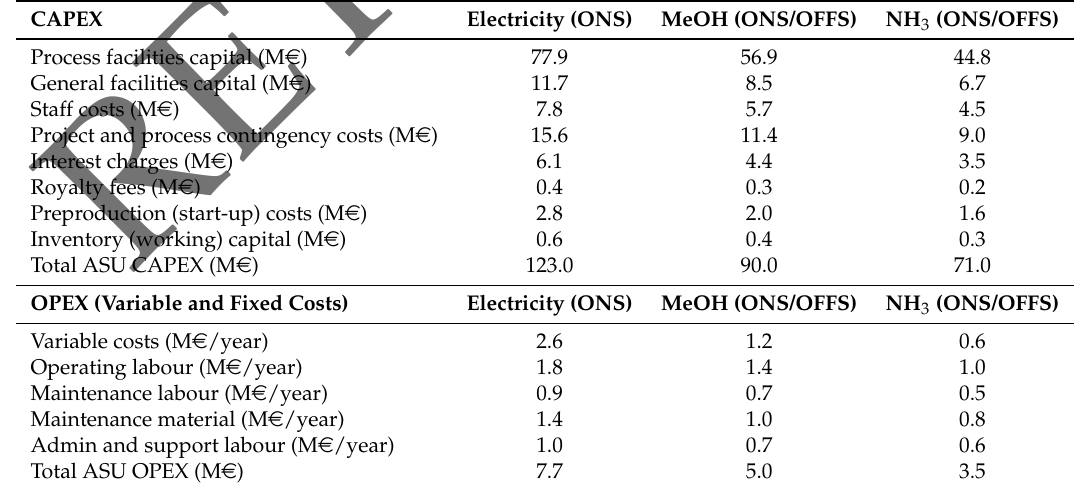
Table 7. CAPEX and OPEX of the air separation process onshore (ONS) and offshore (OFFS) for 20 years of operation, determined using the Integrated Environmental Control Model (IECM)